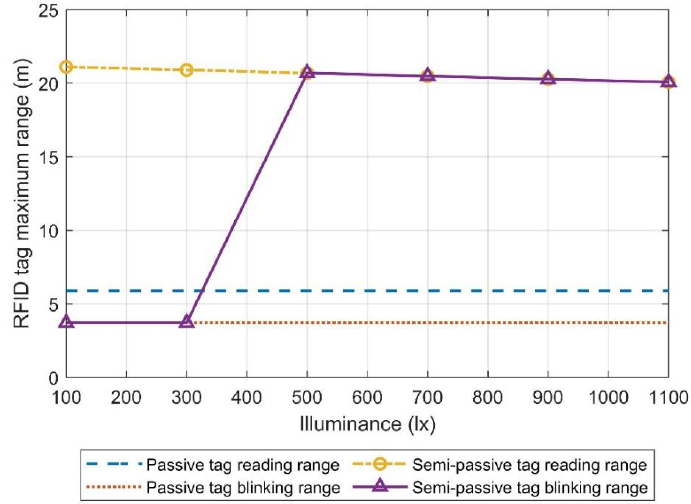
Figure 14. Maximum tag ID reading range and LED blinking range of the proposed semi-passive RFID tag, as a function of illuminance.